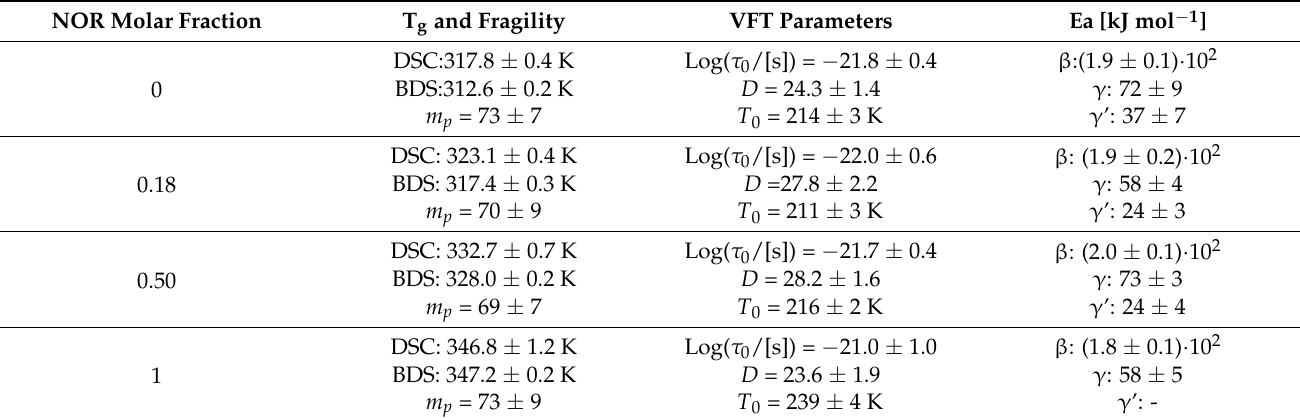
Table 1. Glass transition and fit parameters of selected samples. T g and Fragility VFT